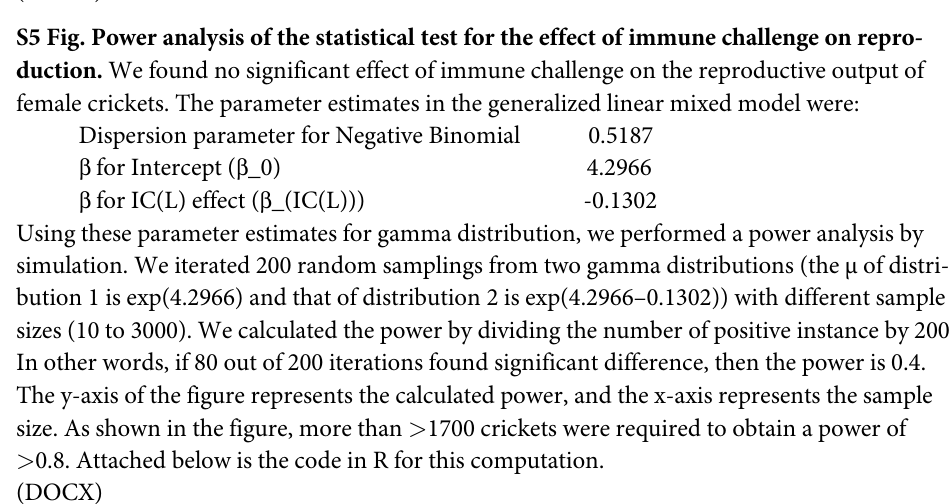
S4 Table. Summary of generalized linear mixed models for immune measures over